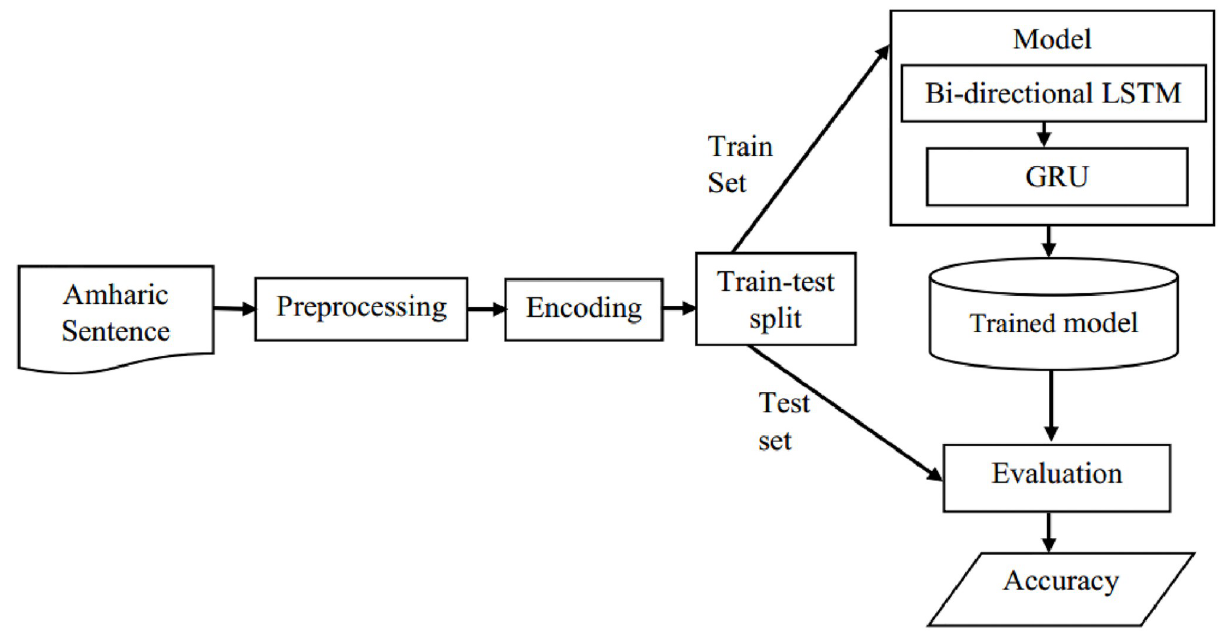
Fig 1. Proposed next word prediction